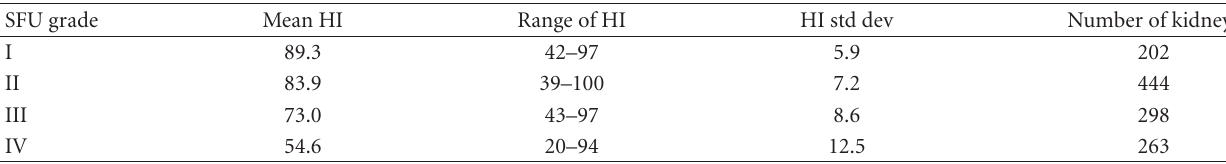
Table 1: Correlation of HI to HN